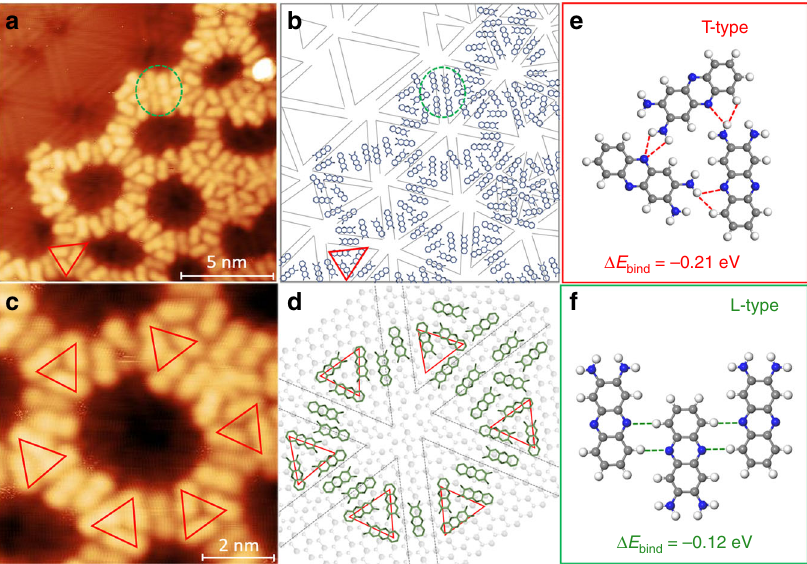
Fig. 4 Model of DAP porous con fi gurations on MoSe 2 surface. a High-resolution STM image (15 × 15 nm 2 ; V S = 1.7 V, I = 60 pA) of DAP porous structure on MoSe 2 . b Schematic of the DAP molecular con fi guration described in a . The red triangle shows a typical triangle trimer con fi guration (T-type) in e , and the green circle shows the linear con fi guration (L-type) of DAP molecules in f . c A close-up STM image (Size: 8 × 8 nm 2 ) of a prototypical DAP pore. d The atomic con fi guration of a typical DAP hexagonal pore on the top of a wagon-wheel pattern. The red triangle highlights the T-type trimer con fi guration, which act as the corner of the hexagonal pores. Here, the binding energy per DAP molecule in trime ( e ) or linear ( f ) con fi guration is de fi ned by Δ